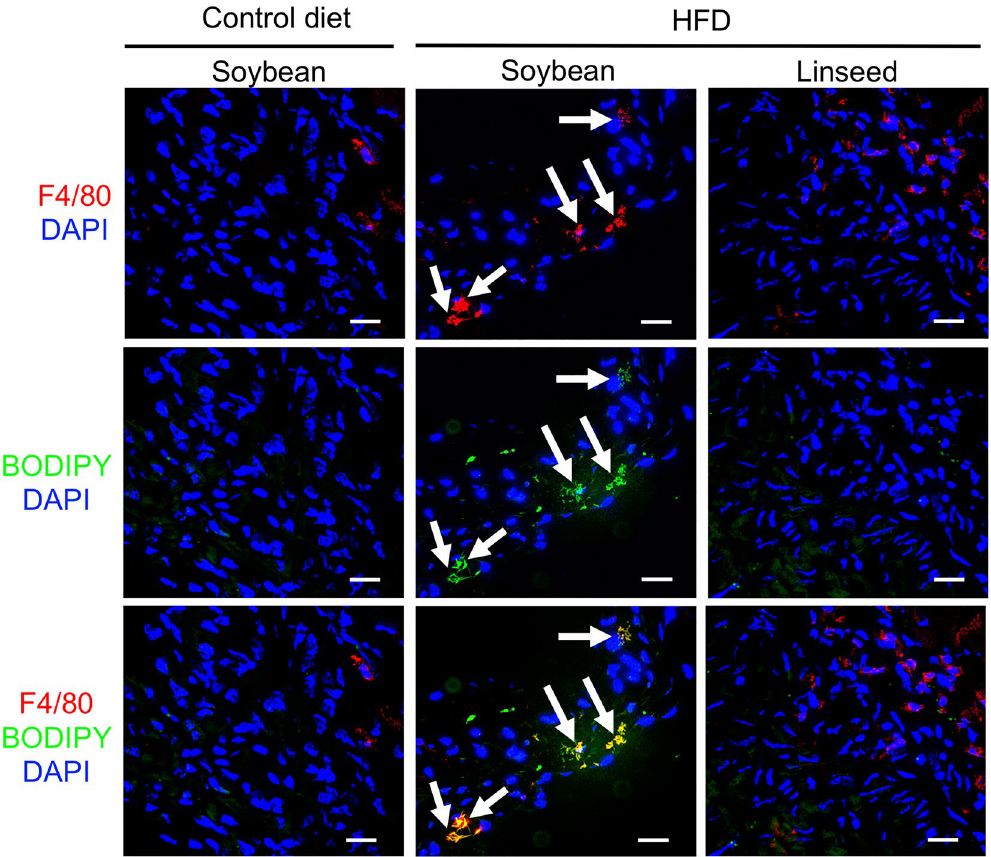
Figure 3. HFD-induced foam cell formation was inhibited by dietary linseed oil. Mice were fed with either control diet with soybean oil, HFD with soybean oil or HFD with linseed oil for 10 months, and histological sections of aortic valve were examined by staining with indicated antibody and reagents. Data are representative of 2 independent experiments (n = 5/group/experiment). Arrows indicate the development of foam cells. Scale bars 20 μm.